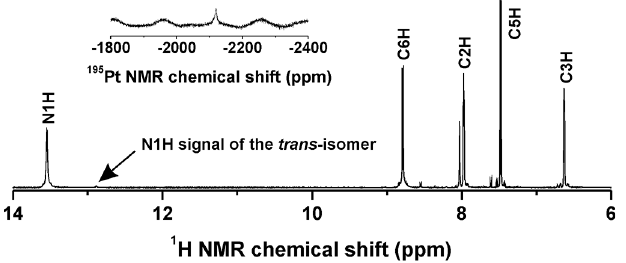
Fig 2. The 1 H NMR and 195 Pt NMR (inset) spectra of 3 in DMF- d 7 . The spectra show the signals of the corresponding atoms and point to chemical and isomeric purity of 3 .